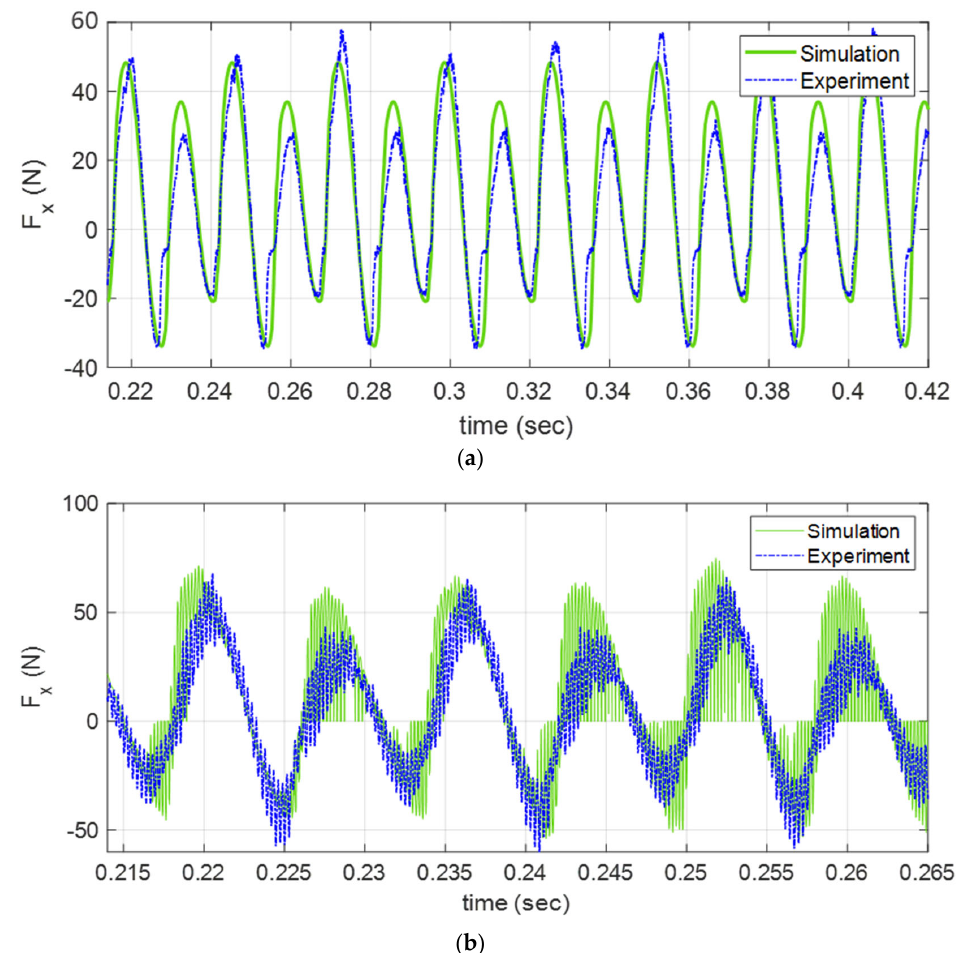
Figure 7. Experimental validation of the cutting force model: ( a ) stable cutting: 2250 rpm spindle and 1.4 mm cut depth; ( b ) unstable cutting: 3750 rpm spindle and 1.4 mm cut depth.